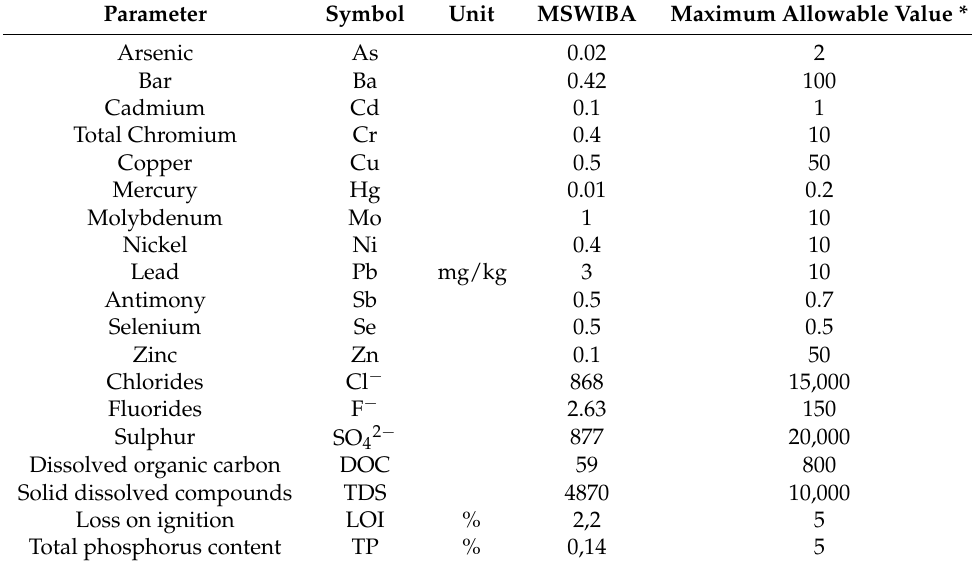
Table 4. Physicochemical properties of MSWIBA.